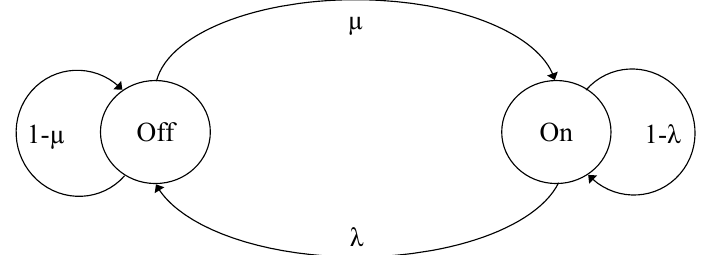
Figure 4. Two state on–off Markov model.